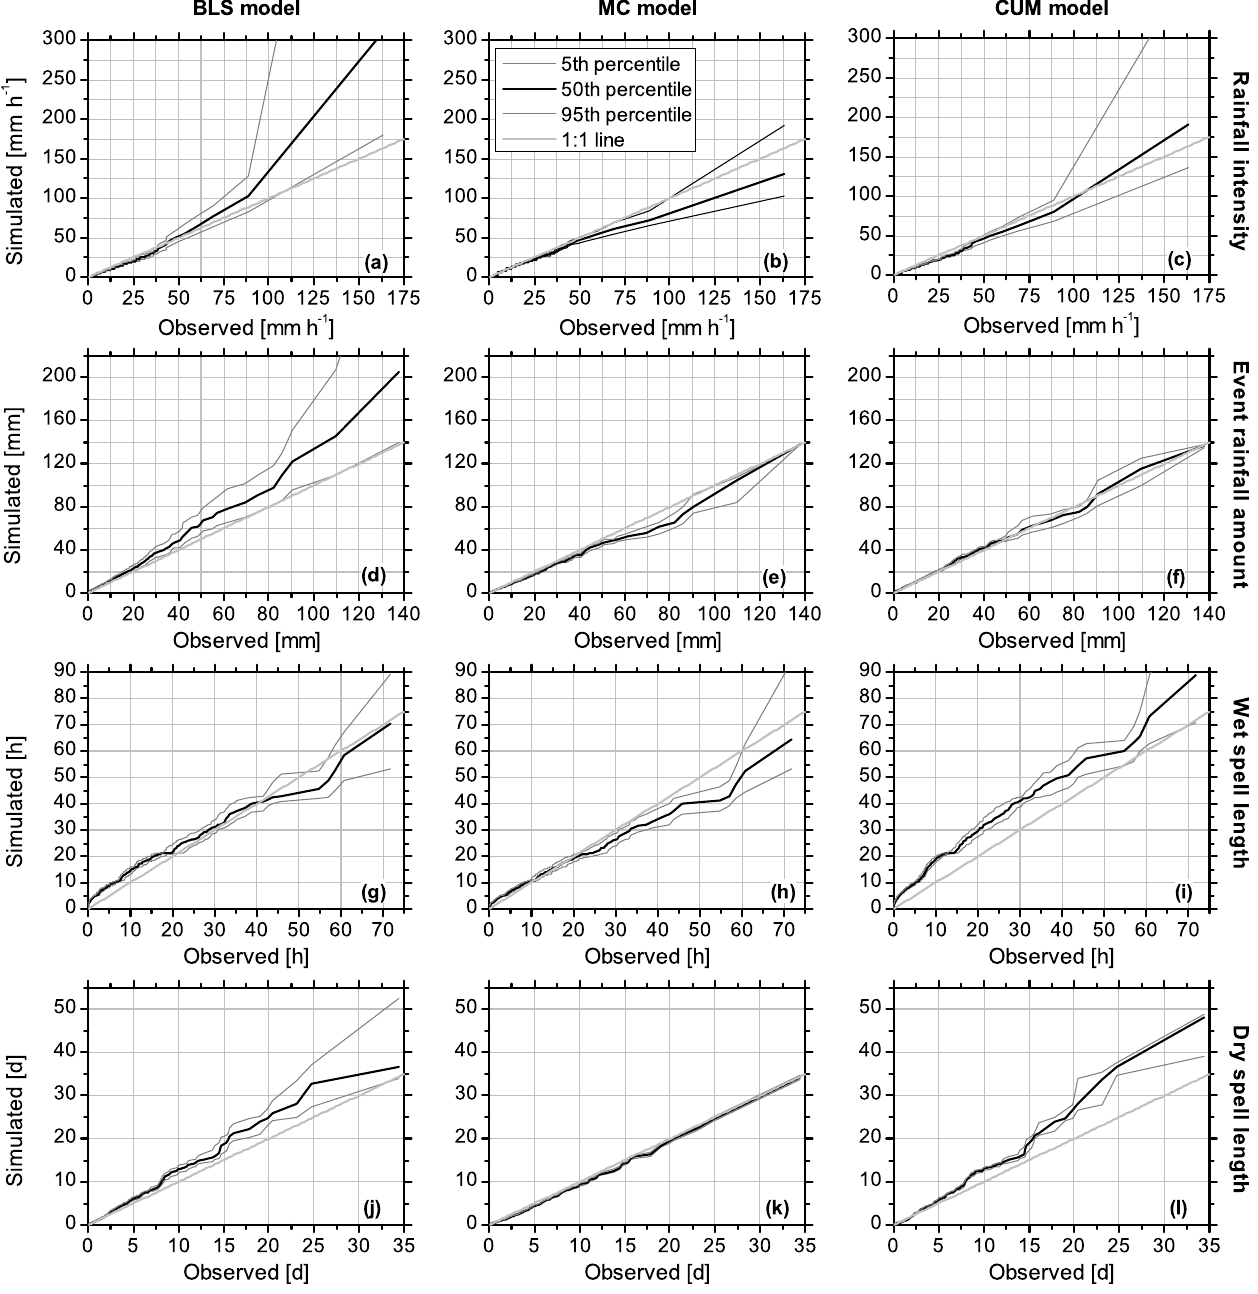
Fig. 7. QQ-plots of four physical summary statistics computed on 100 series simulated by BLS, MC, and CUM models. (a)–(c) Positive rainfall intensity at 5-min time scale. (d)–(f) Event rainfall amount. (g)–(i) Wet spell length. (j)–(l) Dry spell length. Grey lines denote the patterns of the median of each statistics computed on 100 simulations, while light grey lines are the 5th and 95th percentiles.